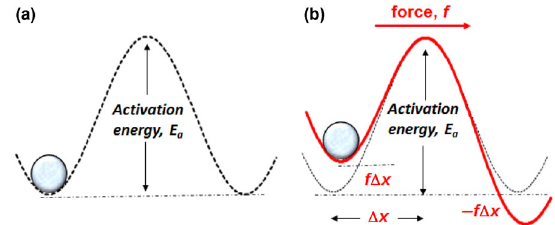
Fig. 1 (a) Activation energy barrier in the absence of an applied force on the molecule shown. (b) Influence of an applied force f on the effective energy barrier. Adapted and reproduced with permission from [5]. Copyright AIP,